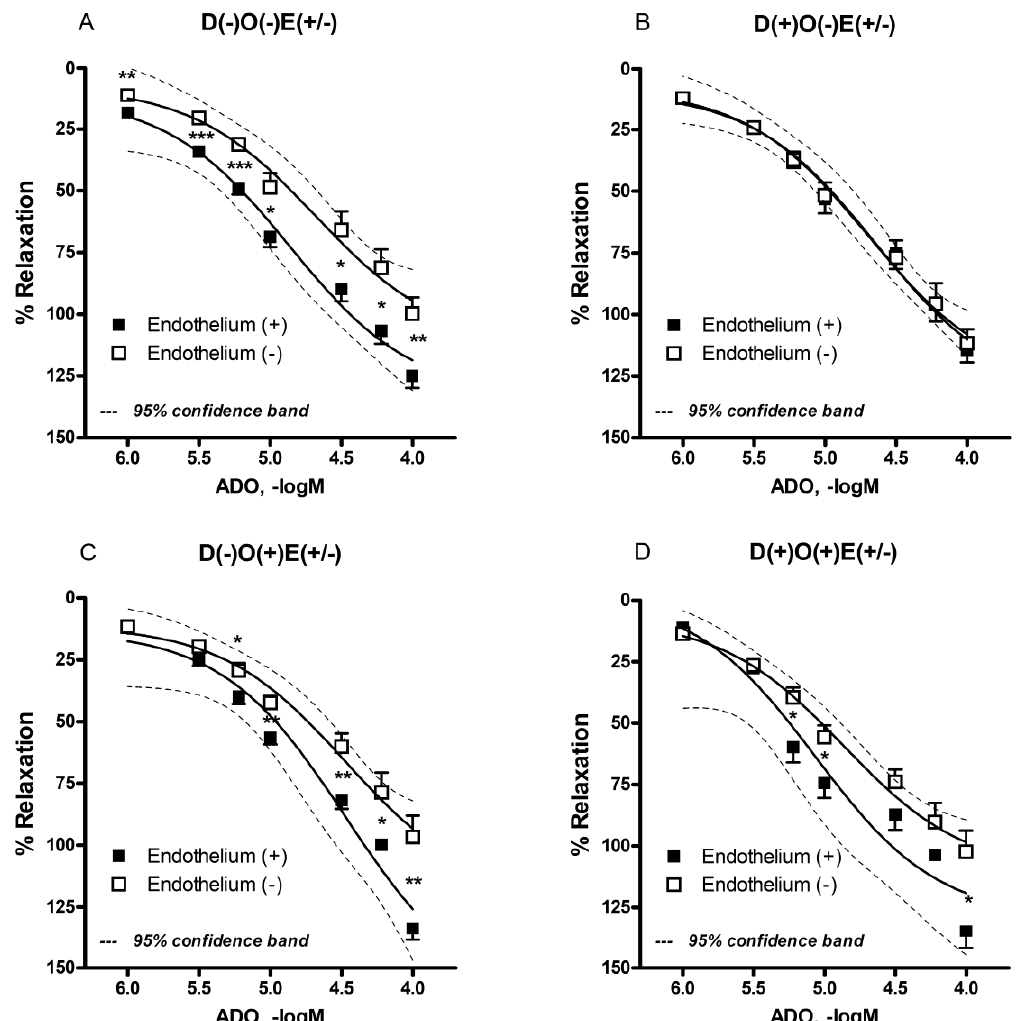
Figure 3. Adenosine-induced relaxation in isolated rat femoral artery with and without endothelium. The femoral artery was obtained from healthy ( A , C ) and diabetic animals ( B , D ). Additionally, the femoral artery was occluded in randomly selected healthy ( C ) and diabetic animals ( D ). Each point is presented as the mean ± S.E.M ( n = 5 – 26). Adenosine-induced vascular relaxation is expressed as the percentage of pre-contraction induced by phenylephrine. * p < 0.05, ** p < 0.01, *** p < 0.001. E = endothelium; D = diabetes; O = occlusion.